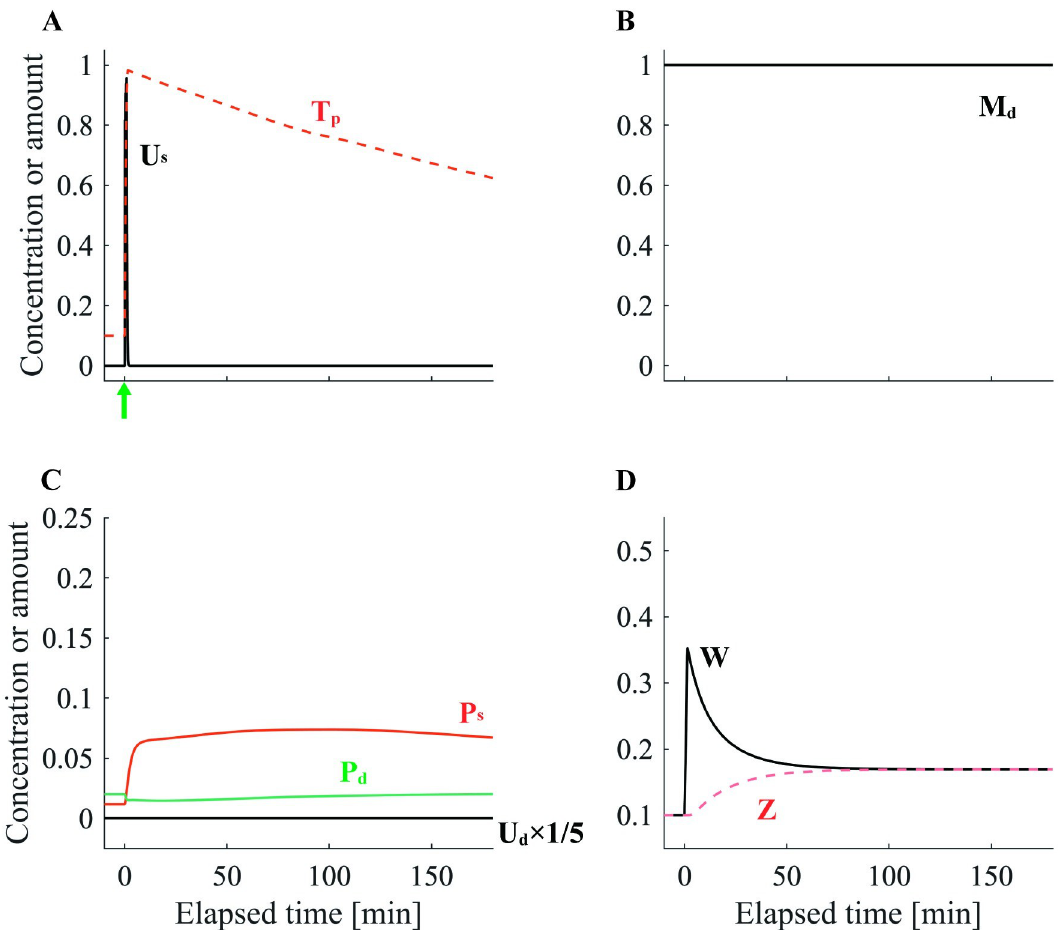
Fig 4. The dynamics of each variable with the e-LTP–inducing stimulation protocol under abundant PRP levels. The variables illustrated in (A)–(D) are the same as those described in the caption of Fig 2. For (A), the green arrow denotes the timing of the e- LTP–inducing stimulation